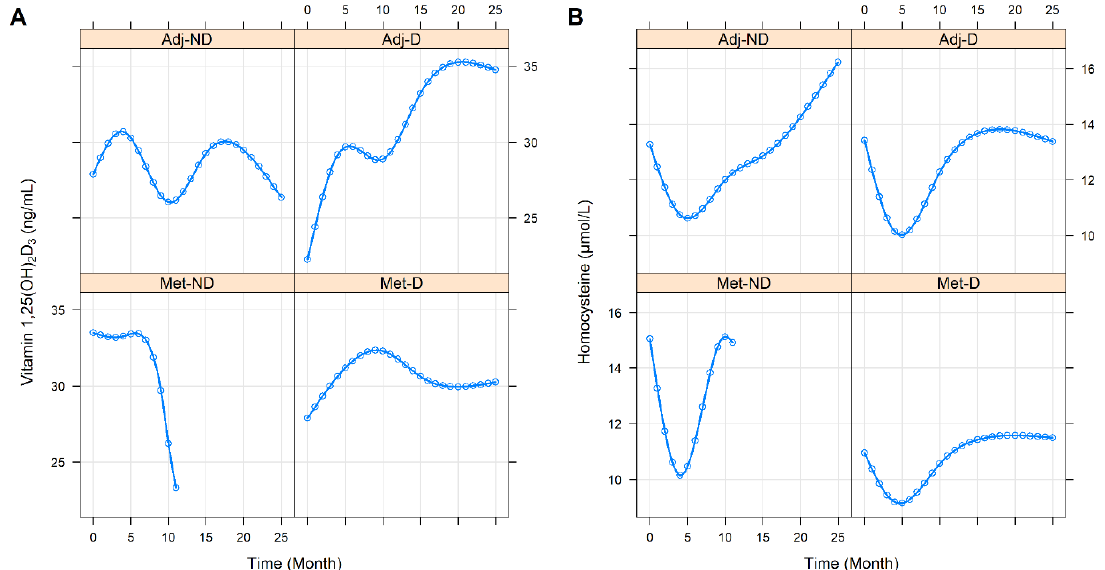
Figure 2. Predictions of average longitudinal changes in vitamin 1,25(OH) 2 D 3 ( A ) and homocysteine ( B ) level of the study groups throughout the first 25 months of the observation time. Adj-ND: patients without metastasis and no vitamin D 3 supplementation; Adj-D: patients without metastasis with vitamin D 3 supplementation; Met-ND: patients with metastasis and no vitamin D 3 supplementation; Met-D: patients with metastasis with vitamin D 3 supplementation.